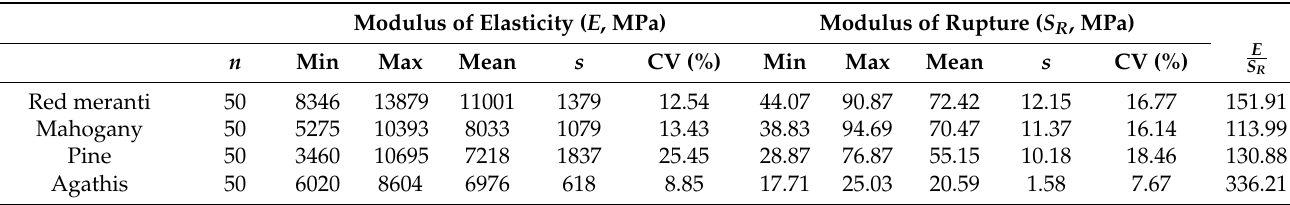
Table 3. The small specimens’ flexural